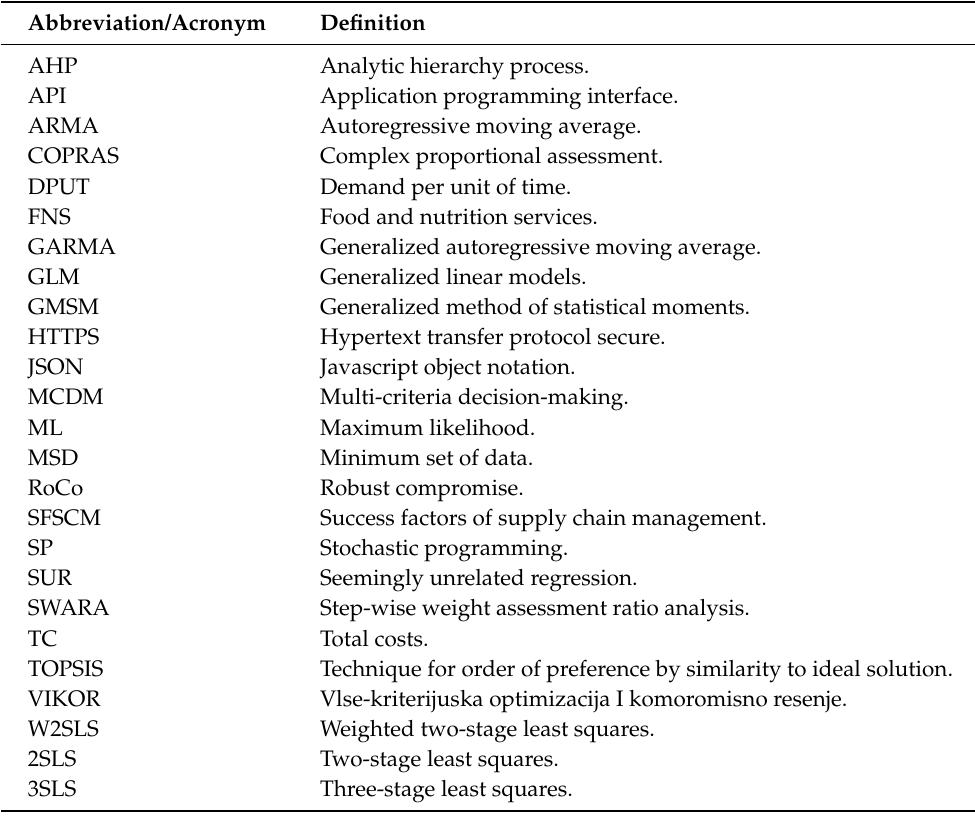
Table 1. Abbreviations and acronyms used in the present